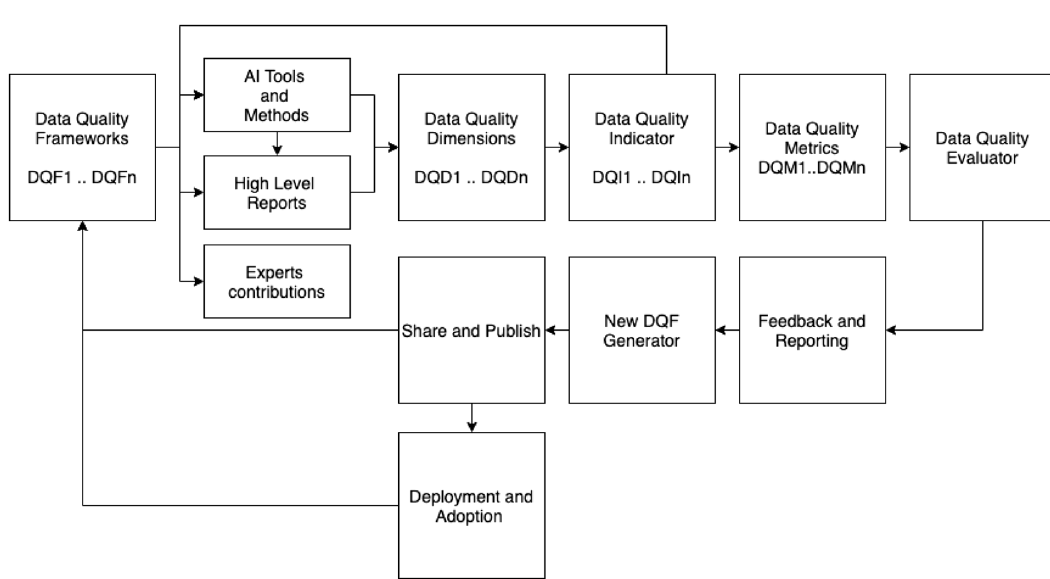
Fig. 1. The suggested data quality framework for improving data